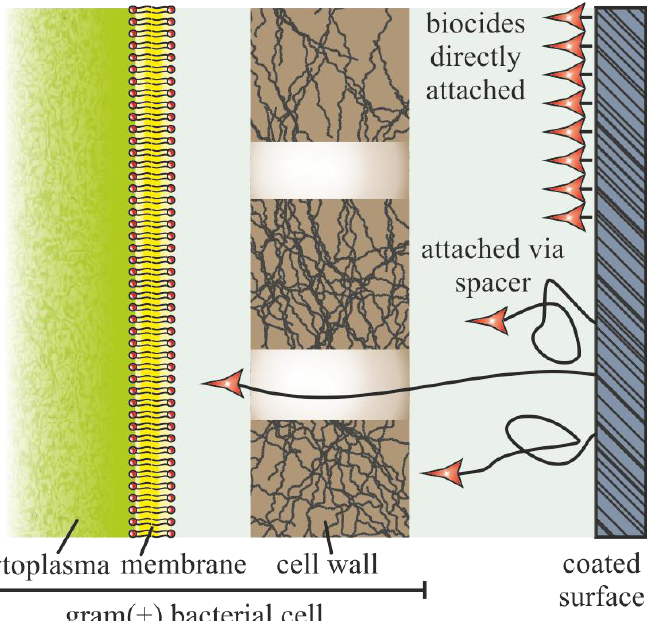
Figure 8. Concept of contact-killing via the polymeric spacer effect. Created according to